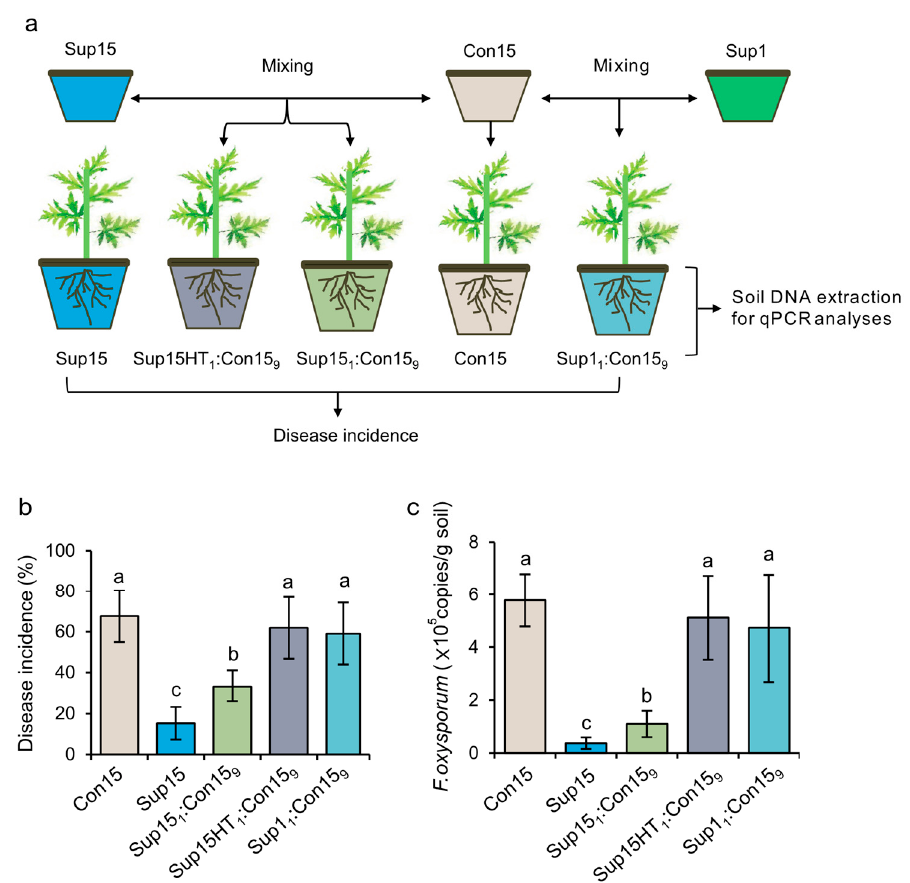
Figure 1. Disease incidence and F. oxysporum density of Chrysanthemum plants in the 15-year conducive soil (Con15), suppressive soil (Sup15), conducive soil mixed with 10% (w / w) of Sup15 (Sup15 1 :Con15 9 ) or heat-treated Sup15 (Sup15HT 1 :Con15 9 ), and Con15 amended with 10% (w / w) of one-year suppressive soil (Sup1 1 :Con15 9 ). ( a ) Experimental scheme of pot designs for assessing soil suppressiveness to Fusarium pathogens. ( b ) Disease incidence in di ff erent treatments. ( c ) Quantification of F. oxysporum density in the rhizosphere soils by qPCR. Data are means ± SE. Di ff erent letters above the bars indicate statistically significant di ff erences by Tukey’s HSD test.